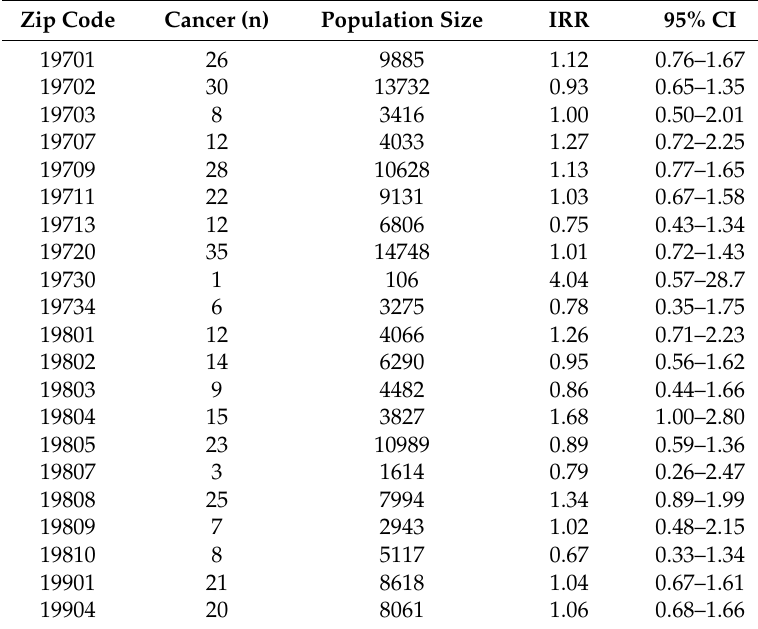
Table 2. Incidence risk ratio of pediatric cancer by zip